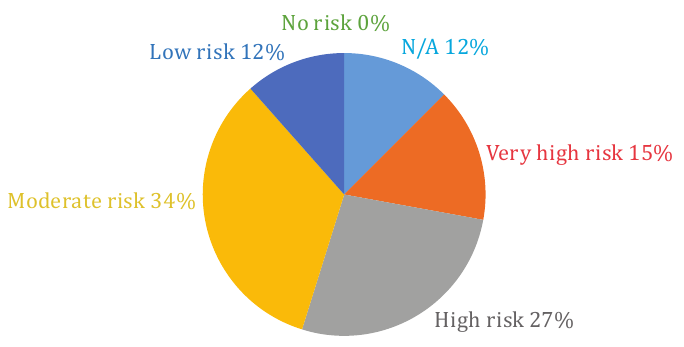
Figure 16. Rating of Bearing defects